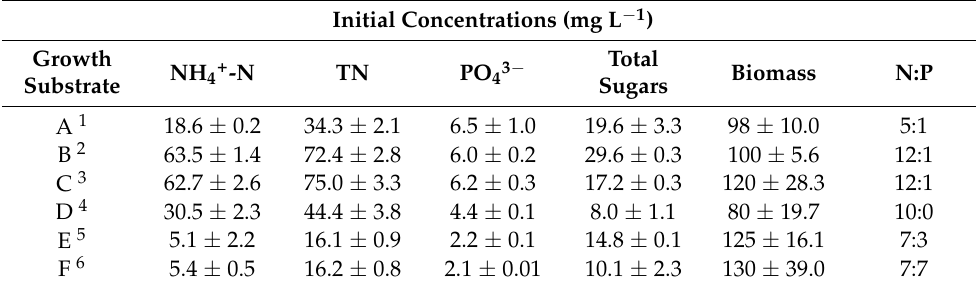
Figure 1. Effect of salinity and substrate composition on the biomass production of T. striata . Experimental sets: ( a ) A (salinity 3.9 ± 0.1%, N:P ≈ 5), B (salinity 3.9 ± 0.1%, N:P ≈ 12), ( b ) C (salinity 2.8 ± 0.1%, N:P ≈ 12), D: (salinity 2.8 ± 0.1%, modified F/2), E (salinity 2.8 ± 0.1%, Nutri-Leaf 30-10-10 without NaHCO 3 ), and F (salinity 2.8 ± 0.1%, Nutri-Leaf 30-10-10 with NaHCO 3 ). Table 1. Initial biomass and nutrient concentrations of all growth substrates tested.